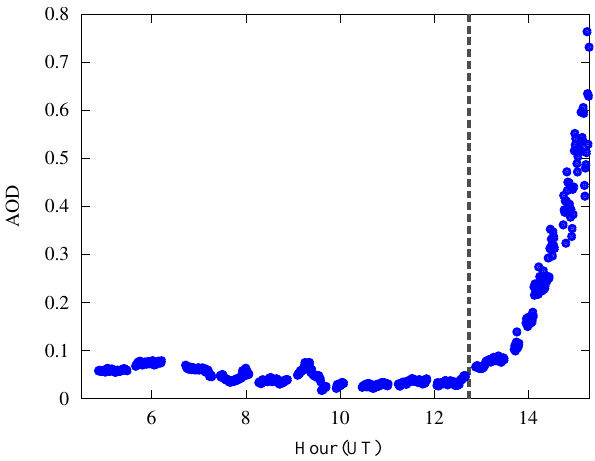
Figure 15. Effect of pointing inaccuracies on Brewer AOD esti- mates (day 128). The vertical line represents the time when the iris border starts cutting the sun